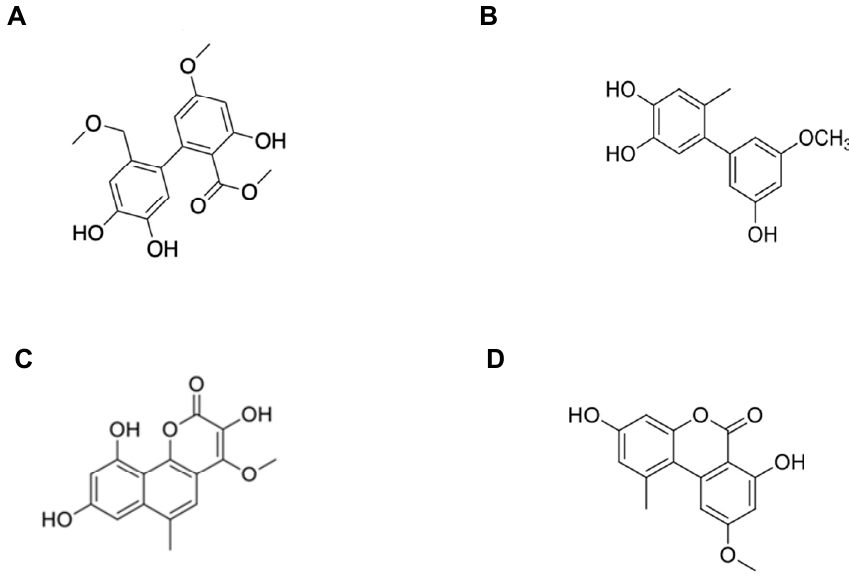
Figure 1. Structure of isolated compounds 1 – 4 ( A – D ).